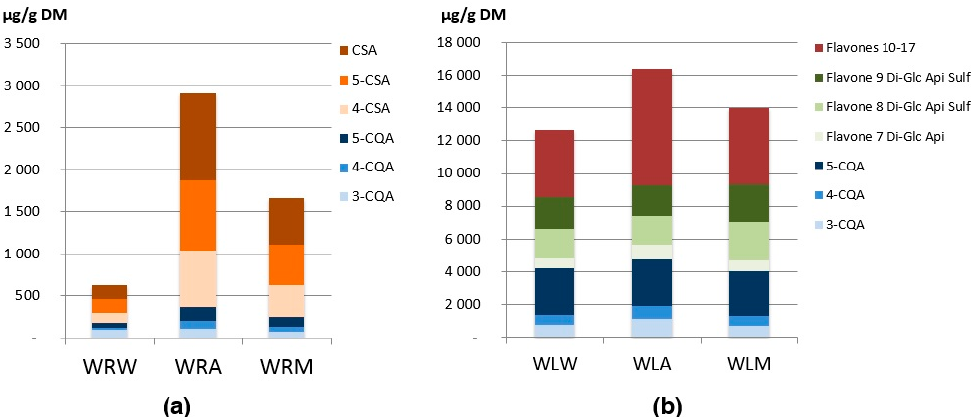
Figure 4. Chemical composition of: ( a ) root extracts; and ( b ) leaflet extracts of Euterpe oleracea ;